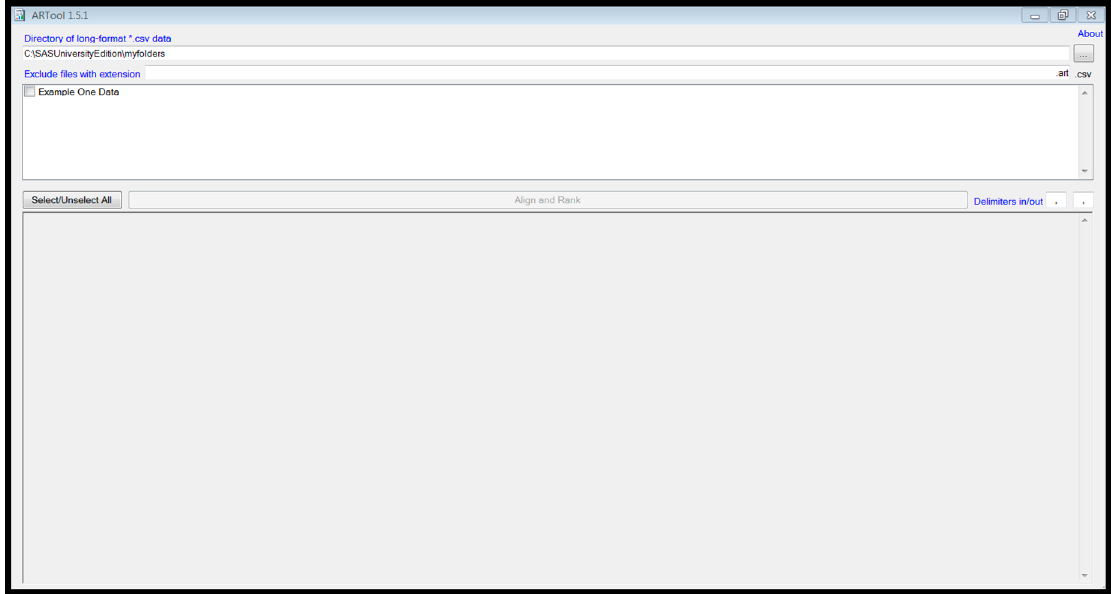
Figure 1. ARTool window at startup.